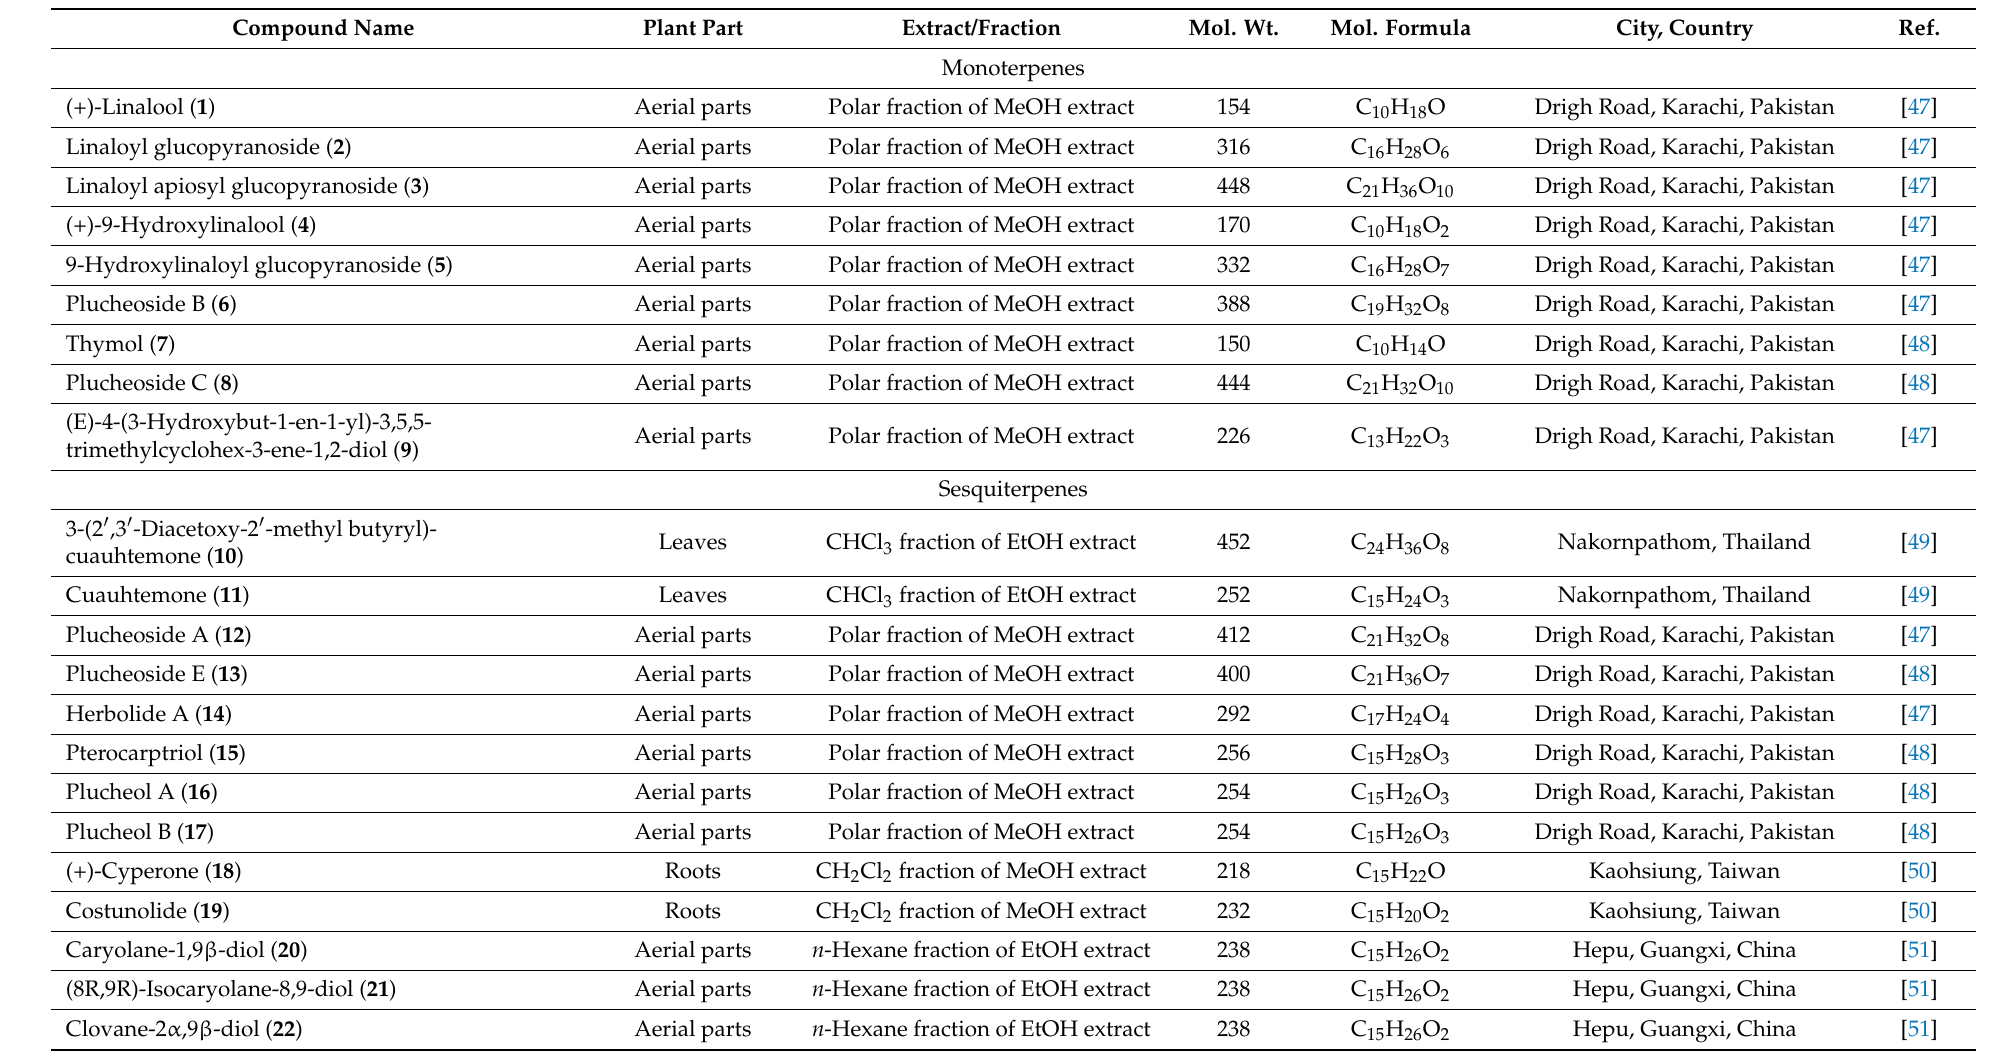
Table 1. List of reported metabolites from Pluchea indica